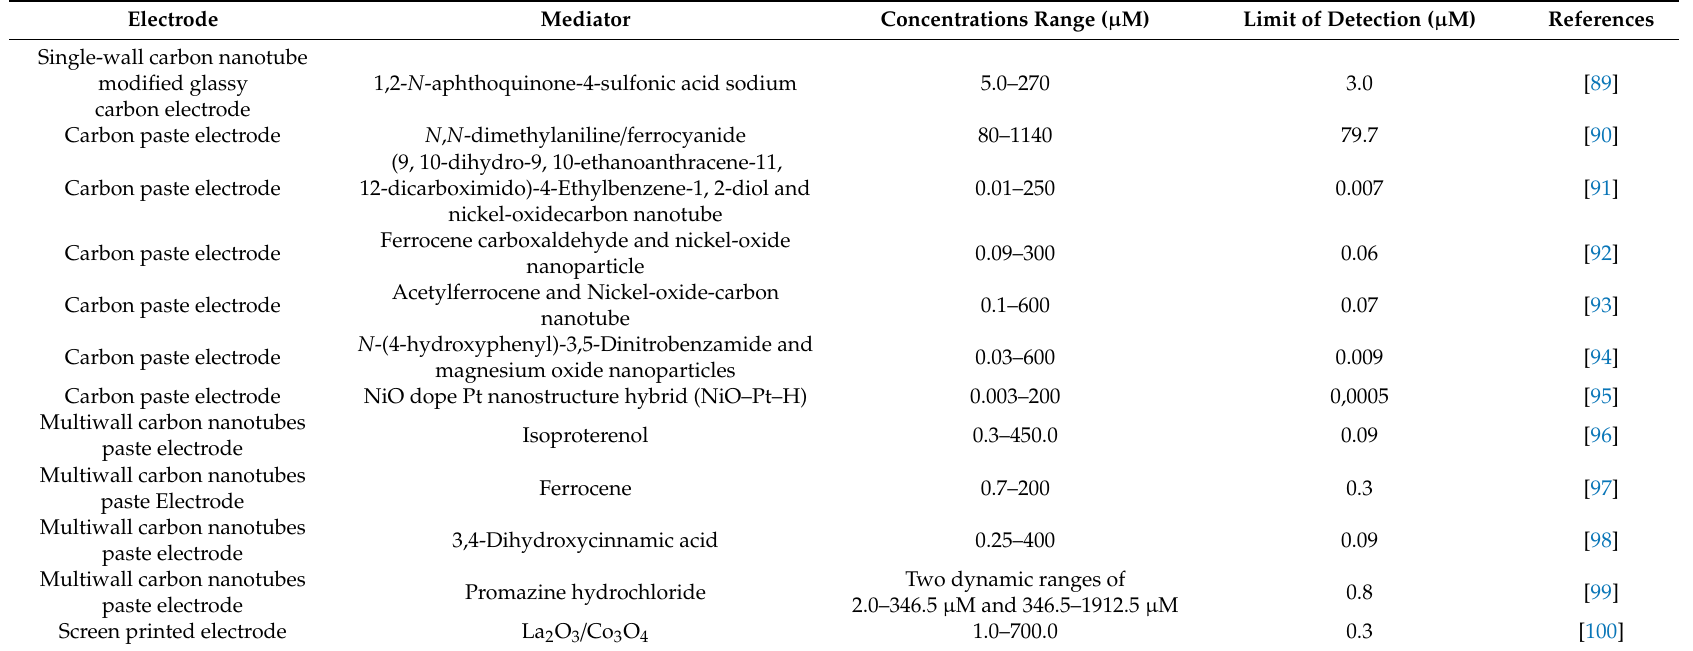
Table 5. Electrochemical detection